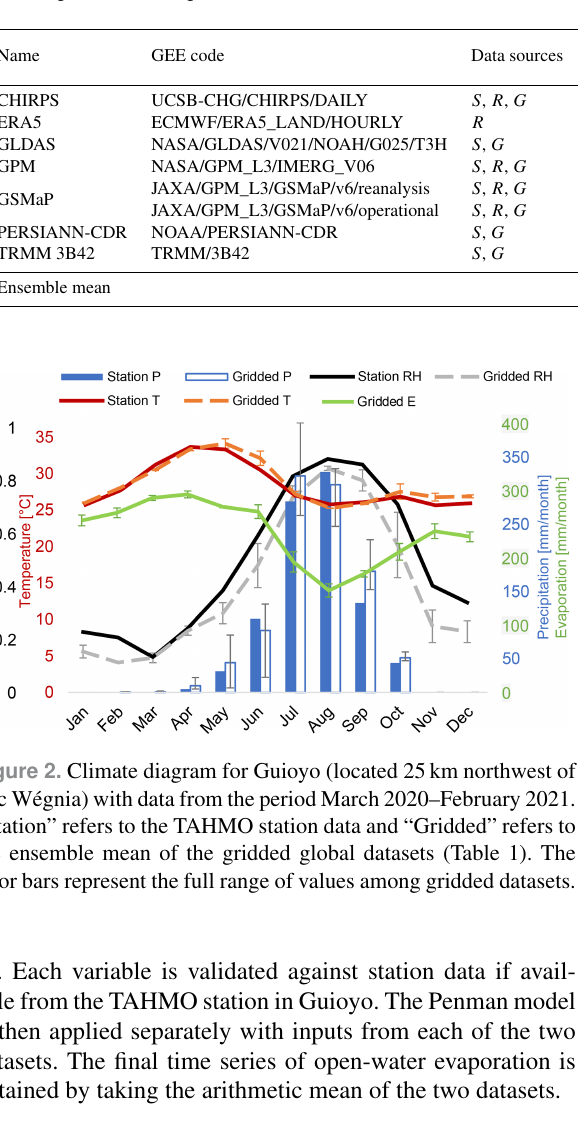
Table 1. Meteorological datasets used in this study. Also indicated are wet-season precipitation trends for Lac Wégnia that are significant at the 0.01 level (the values in brackets represent the precipitation change from 2000 to 2020 in percent). G : gauge; S : satellite; R : reanalysis; P : precipitation; T a : air temperature; T d : dew-point temperature; W : wind, RAD: solar radiation, Q air : specific humidity; Pr: surface pressure; NP: near present; POS: positive trend; N: no trend.